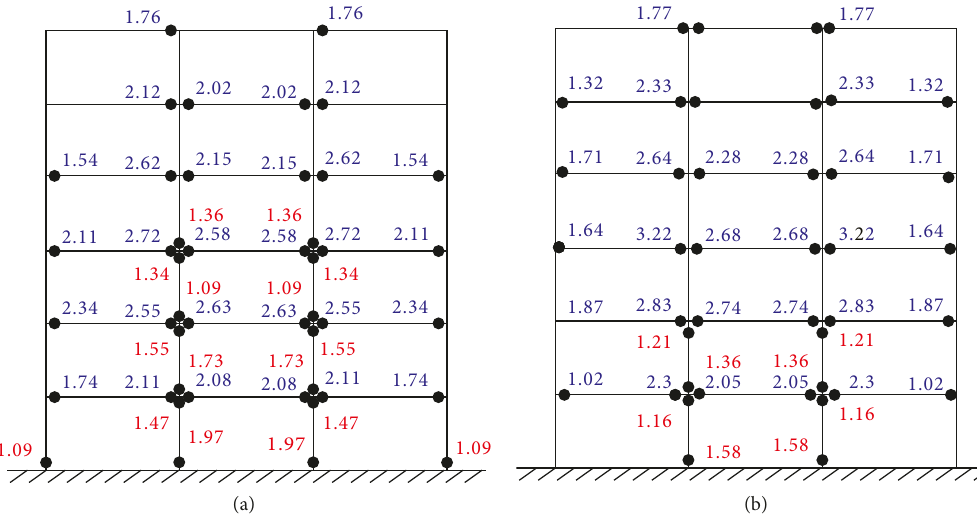
Figure 22: Plastic hinge distribution with 8-degree (0.40 g) fortification intensity. (a) Considering the beam-to-column linear stiffness ratio limit values. (b) Not considering the beam-to-column linear stiffness ratio limit